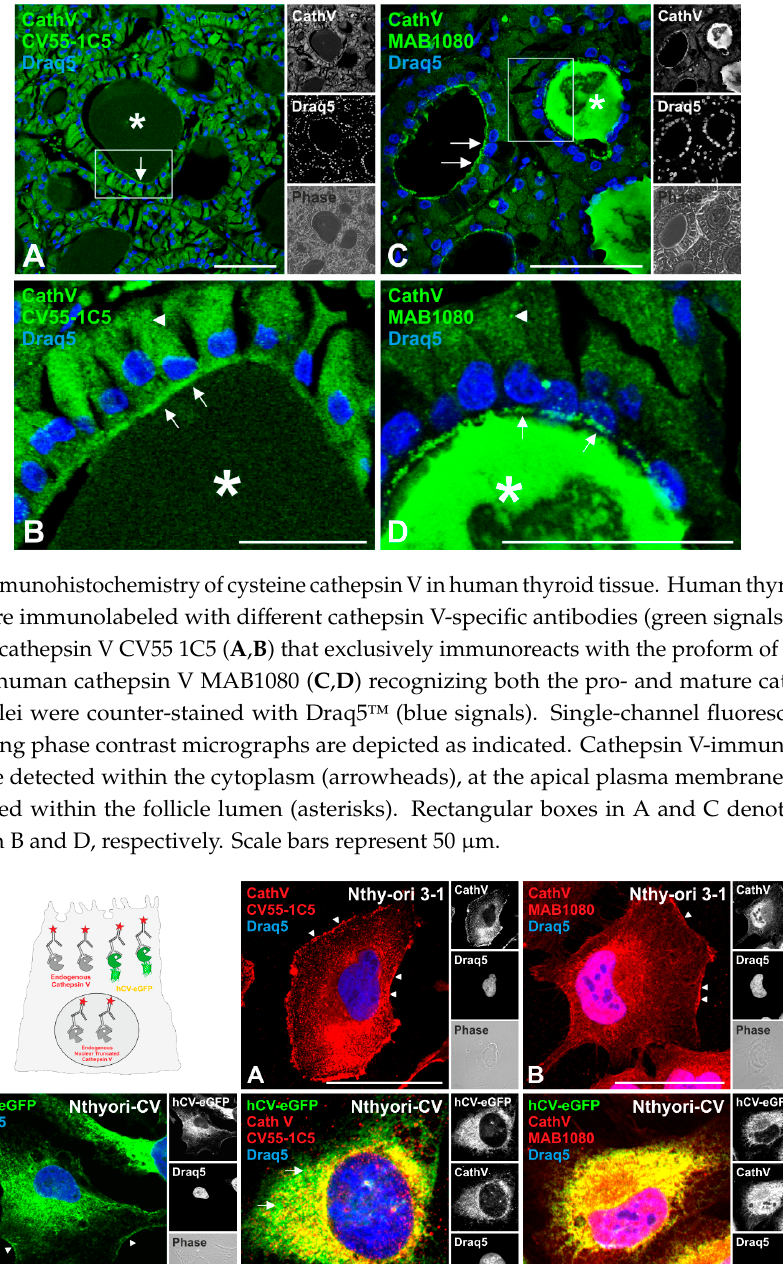
of colocalizing signals from cathepsin V antibodies and hCV-eGFP. The sketch (upper left panel) outlines this approach schematically. Nuclei were counter-stained with Draq5 ™ (blue signals). Pink signals are indicative of colocalizing signals from cathepsin V antibodies and nuclear Draq5 ™ staining. Single-channel fluorescence and corresponding phase contrast micrographs are depicted as